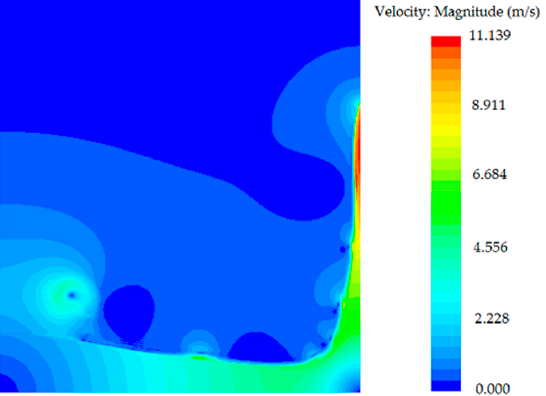
Figure 10. Pressure field in the STAR-CCM+ simulation ( .